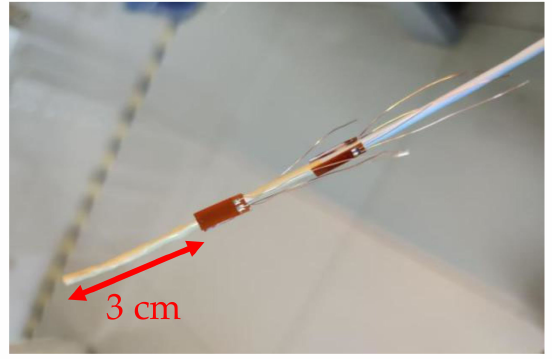
Figure 8. The catheter with strain gauges.